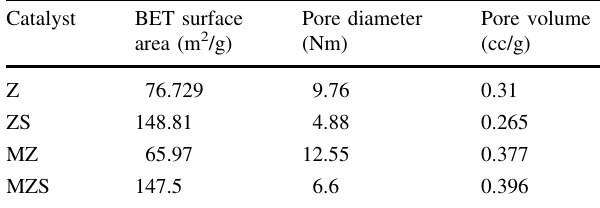
Table 2 Physical properties of zirconia prepared using sulfate and